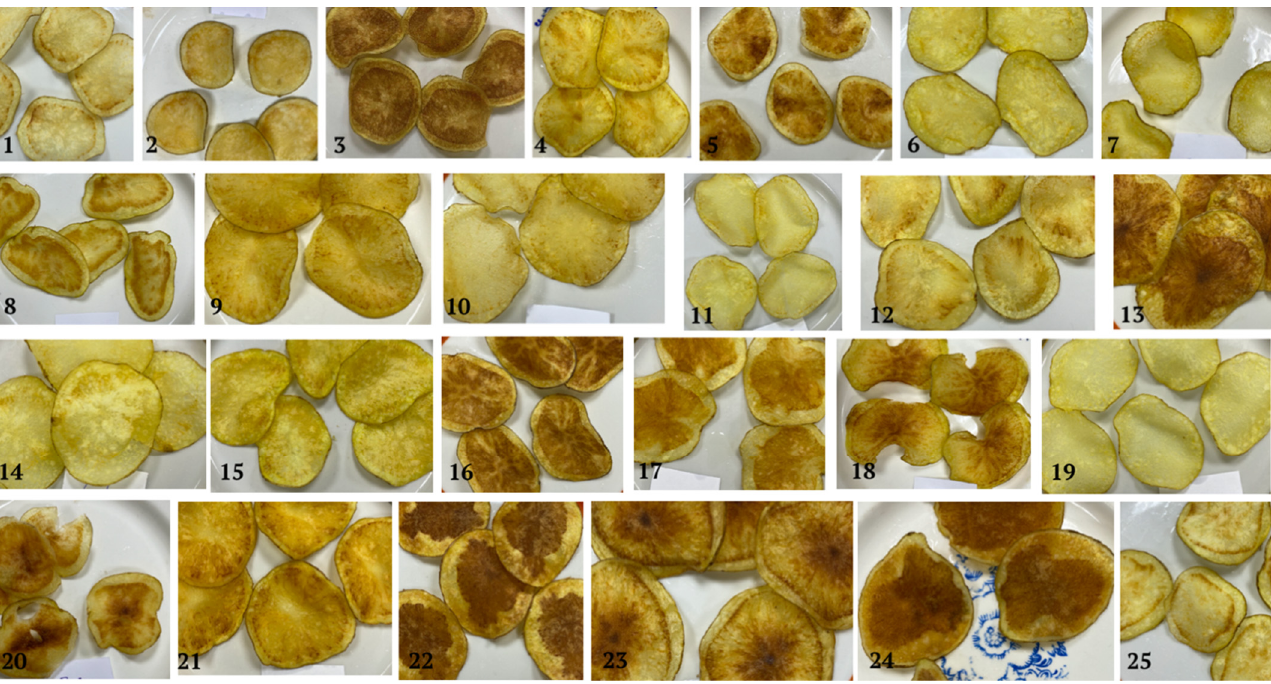
Figure 1. Color of chips prepared from the hybrid samples.